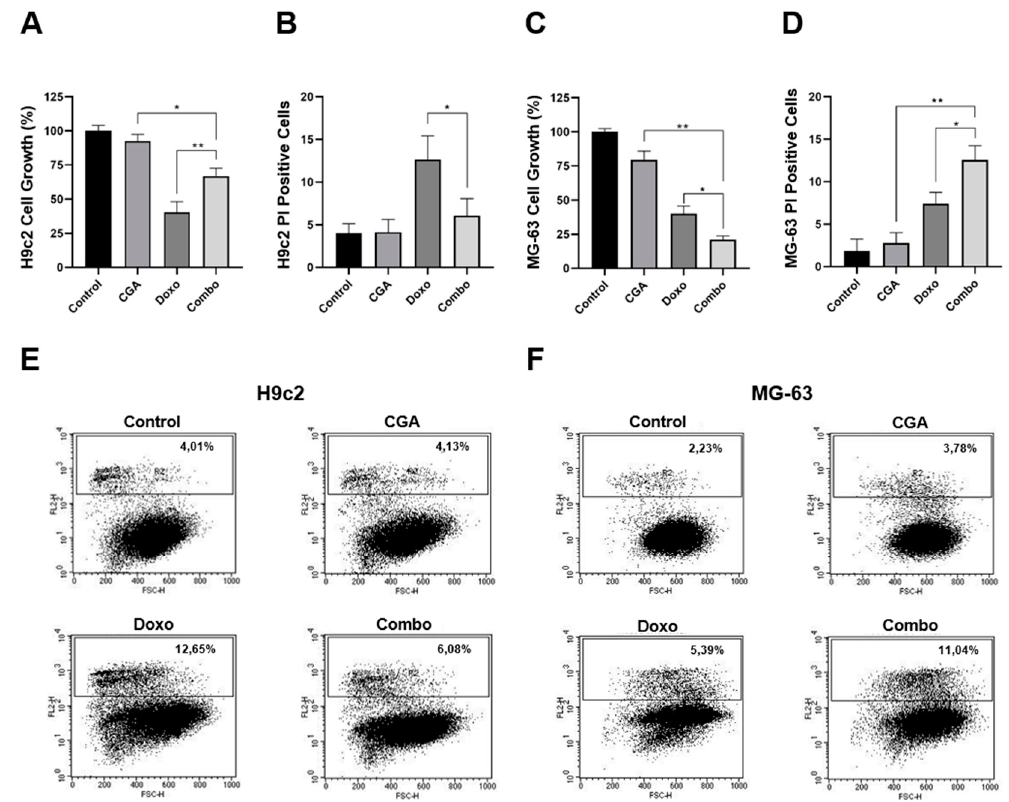
Figure 6. Evaluation of CGA, Doxo, and CGA plus Doxo-mediated effect on cell growth and death in H9c2 and MG-63 cells. H9c2 and MG-63 were treated and not (control) with 200 µ M CGA, 0.1 µ M Doxo, and CGA plus Doxo (combo) for 48 h. Later, the percentage of cell growth ( A , C ) as well as cell death ( B , D ) was established. Representative dot-plots are shown in ( E , F ). * p < 0.05, ** p < 0.01 by an unpaired two-tailed t -test. Experiments were repeated thrice.